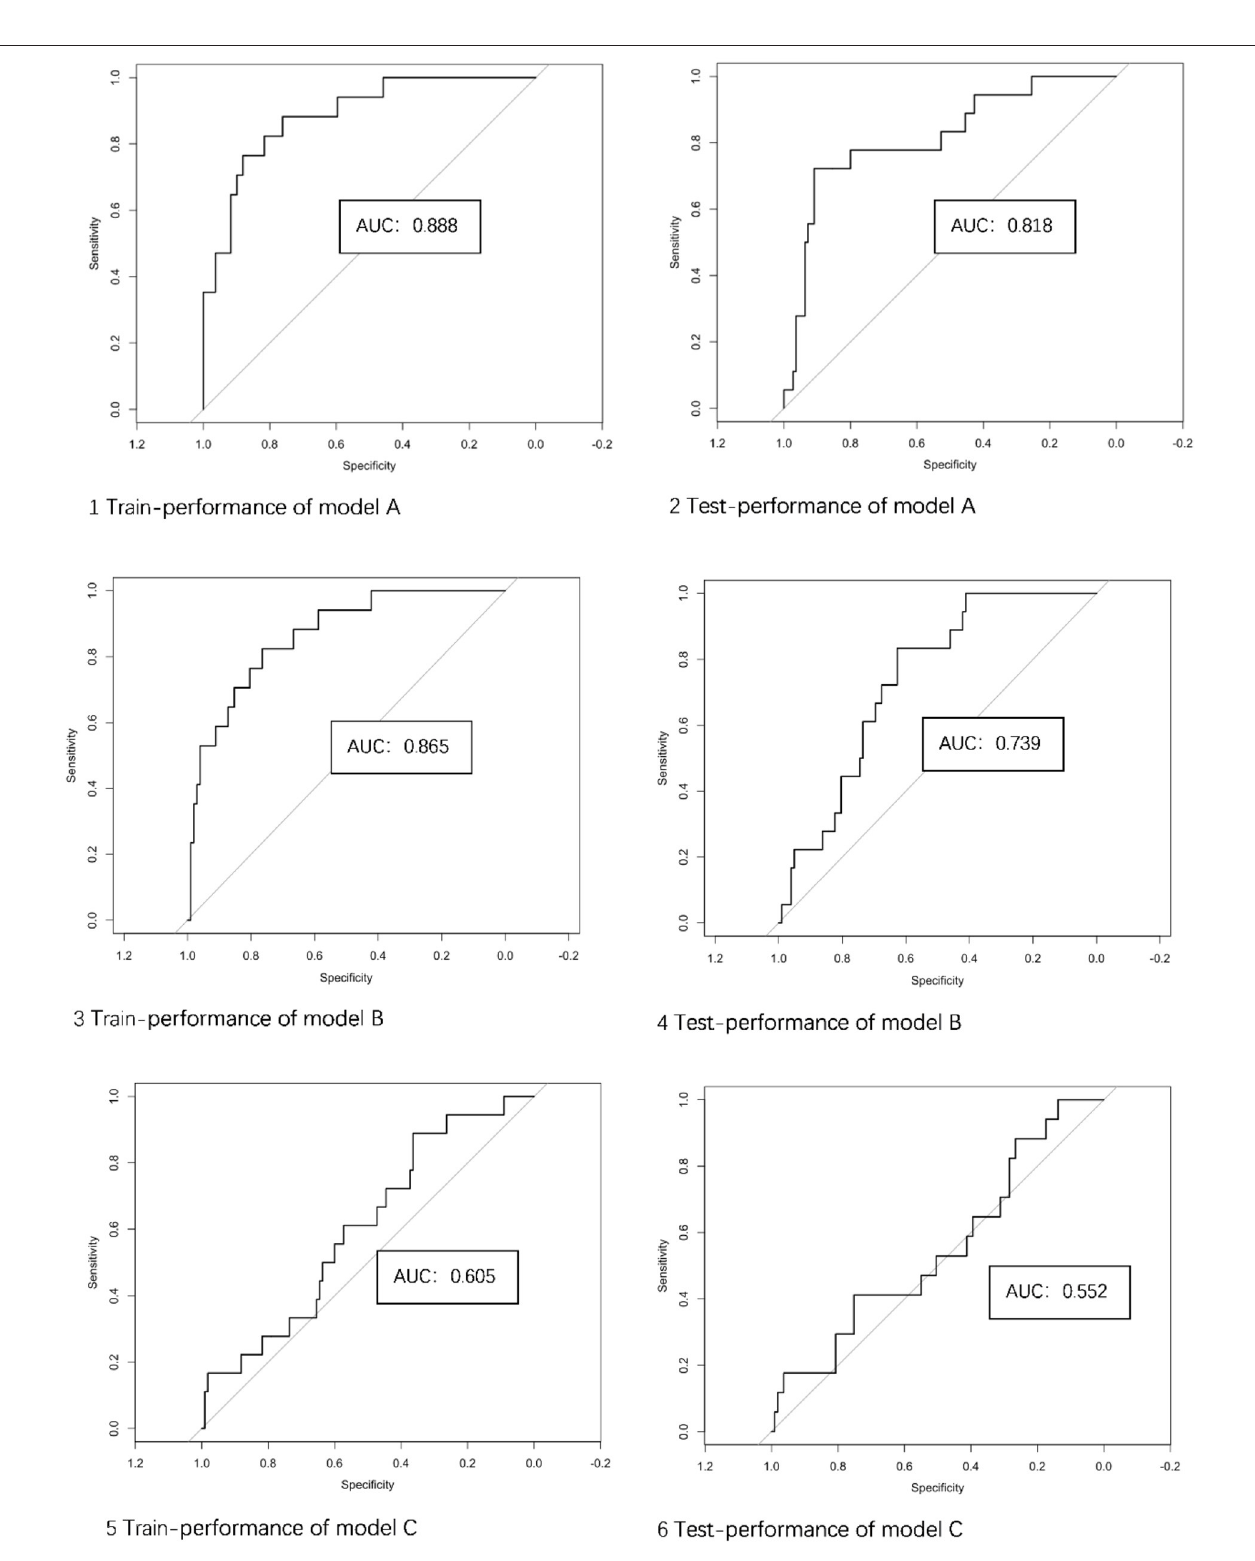
FIGURE 4 | The performance of 3 models in the training and testing sets. AUC, area under the curve; Model A, model of traditional morphological features; Model B, model of Radiomics derived features; Model C, model of Radiomics derived morphological features.